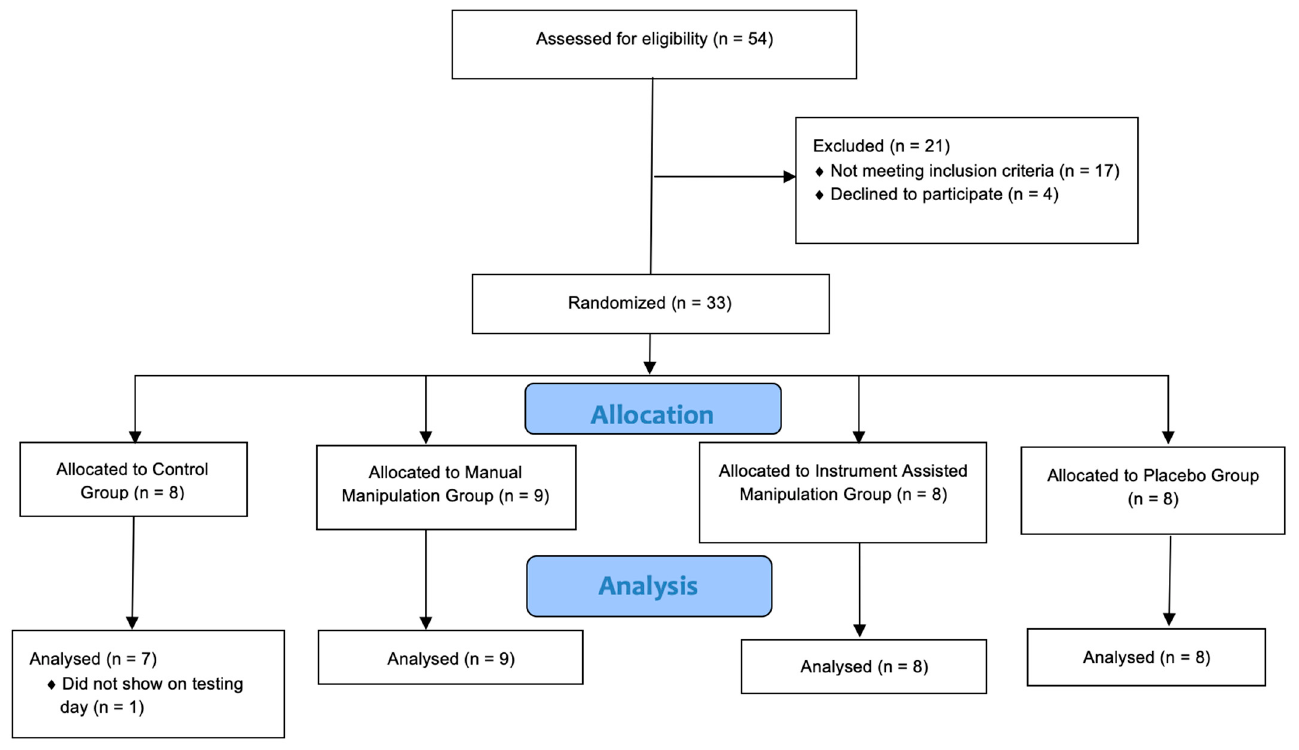
Figure 1. Flow diagram depicting the study design.